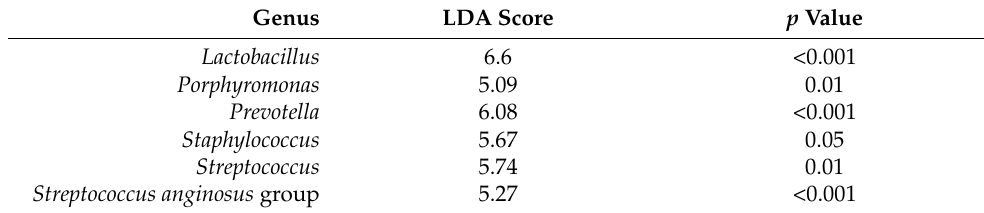
Table 2. Biomarkers at the bacterial genus level. The linear discriminative analysis (LDA) effect size (LEfSe) test shows that the bacterial genera were significantly different in the comparison of the samples from the unexplained infertility group with those of the explained infertility group. The relative abundances of the bacterial genera are shown in Figure 2. Positive values of LDA scores (log 10) are indicative of enriched taxa in a given group.